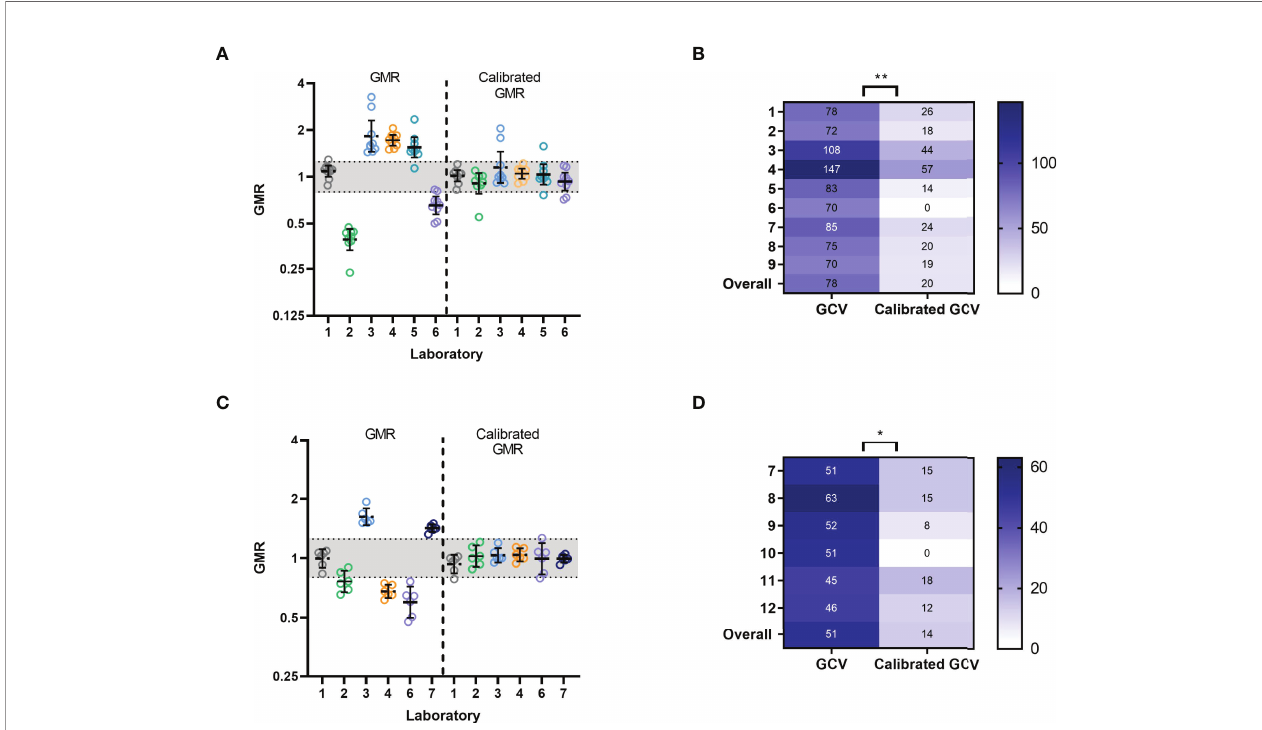
FIGURE 5 | Calibration of Precision data and Robustness data : (A) Precision data: geometric mean ratios (GMR) for uncalibrated and calibrated ELLA-NI titres by lab per run. For each laboratory and run, a calibration factor was calculated using sample 6 (see materials and methods, sample with a mid-range titre) and applied to titres. The indicative range of 0.8-1.25 is shaded in grey. Geometric mean and 95% CI error bars are shown in black. (B) Precision data: %GCV for log 10 transformed titres before and after calibration with sample 6. ** indicates signi fi cance using the Wilcoxon matched pairs test [P=0.0039] (C) Robustness data: GMR of ELLA-NI titres for samples 7-12 are plotted before and after calibration with serum sample 10 (selected as a sample with a mid-range titre). The indicative range of 0.8-1.25 is shaded in grey. Geometric mean and 95% CI error bars are shown in black. (D) Robustness data: %GCV for log 10 transformed titres before and after calibration with sample 10. * indicates signi fi cance using the Wilcoxon matched pairs test [P=0.0313].